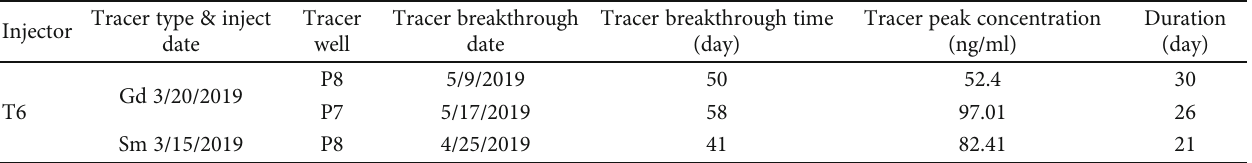
Figure 18: Dividing the coe ffi cient diagram of the T6 well group. Table 3: Tracer test results of the T6 well